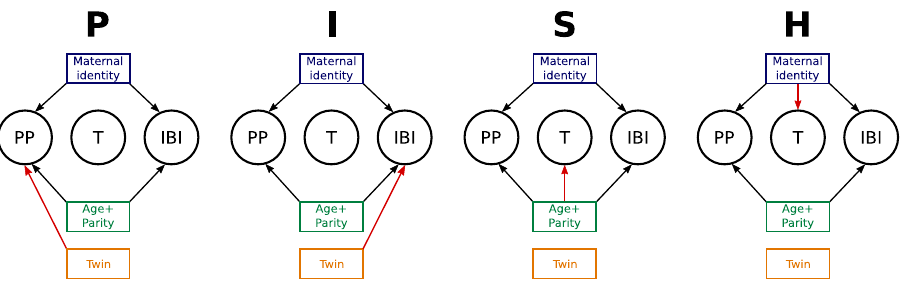
Fig. 3 Representation of the four, non-mutually exclusive, candidate mechanisms impacting the relationship between per-birth twinning probability and total births. Circles represent the three life-history events we considered: parity progression (PP), per-birth probability of twinning (T) and interbirth interval (IBI). The rectangles represent the variables potentially shaping these life-history events — maternal age and parity at a given birth (referred to as Age + Parity) and whether the last birth was a twin birth or not (Twin) — as well as a random effect capturing other sources of heterogeneity between mothers (Maternal identity). Black arrows represent relationships assumed in all simulation scenarios. Another random effect capturing differences between populations was also considered for all life-history events and all mechanisms (not shown). Red arrows represent relationships used to activate each mechanism.